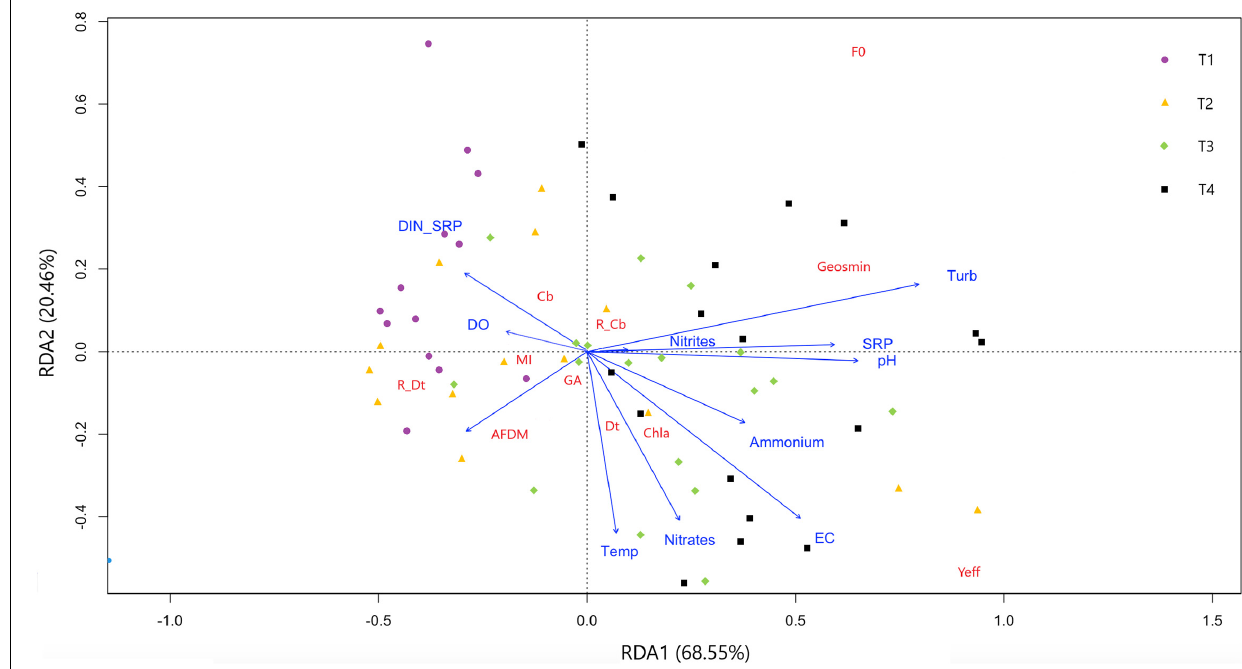
FIGURE 3 | Redundancy discriminant analysis showing response parameters distribution based on drivers evaluated in four different sampling sites in upper Ter River basin (NE Catalonia, Spain) in 2019. Axes 1 and 2 combined explain 89% of variance. Drivers: pH, temperature (Temp), electrical conductivity (EC), dissolved oxygen (DO), turbidity, nitrite (N-NO 2 − ), nitrate (N-NO 3 − ), ammonium (N-NH 4 + ), and phosphate concentration (P-PO 4 − 3 ), and nitrogen to phosphorus ratio (DIN:SRP). Response variables: geosmin, minimum fluorescence yield ( F 0 ), photosynthetic efficiency (Y eff ), chlorophyll- a concentration (Chl a ), ash free dry mass (ADFM), Margalef index (MI), cyanobacteria (Cb), diatoms (Dt) and green algae (GA) biomass, and relative abundance of cyanobacteria (R_Cb) and diatoms (R_Dt).